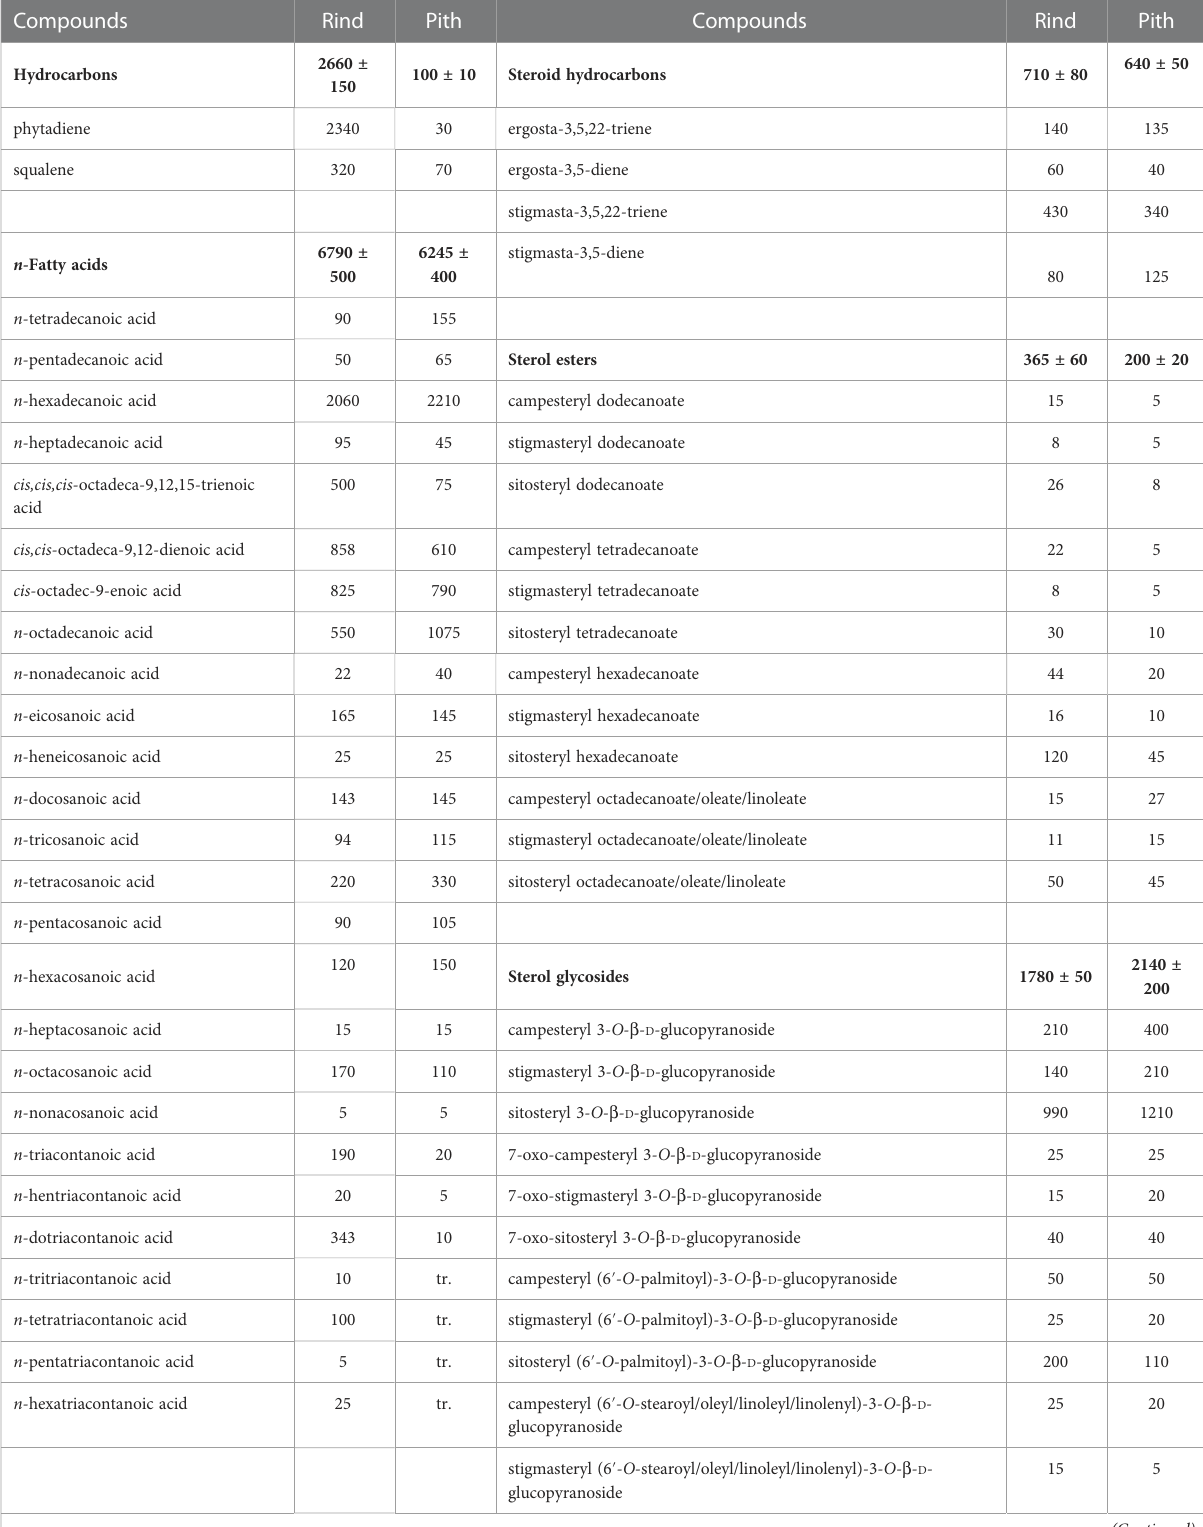
TABLE 1 Composition and abundance (mg/kg, dry-basis) of the lipid compounds identi fi ed in the acetone extracts of the rind and pith of papyrus stems (values are the mean of three technical replicates; values in bold correspond to the total amounts of each group of compounds and the standard